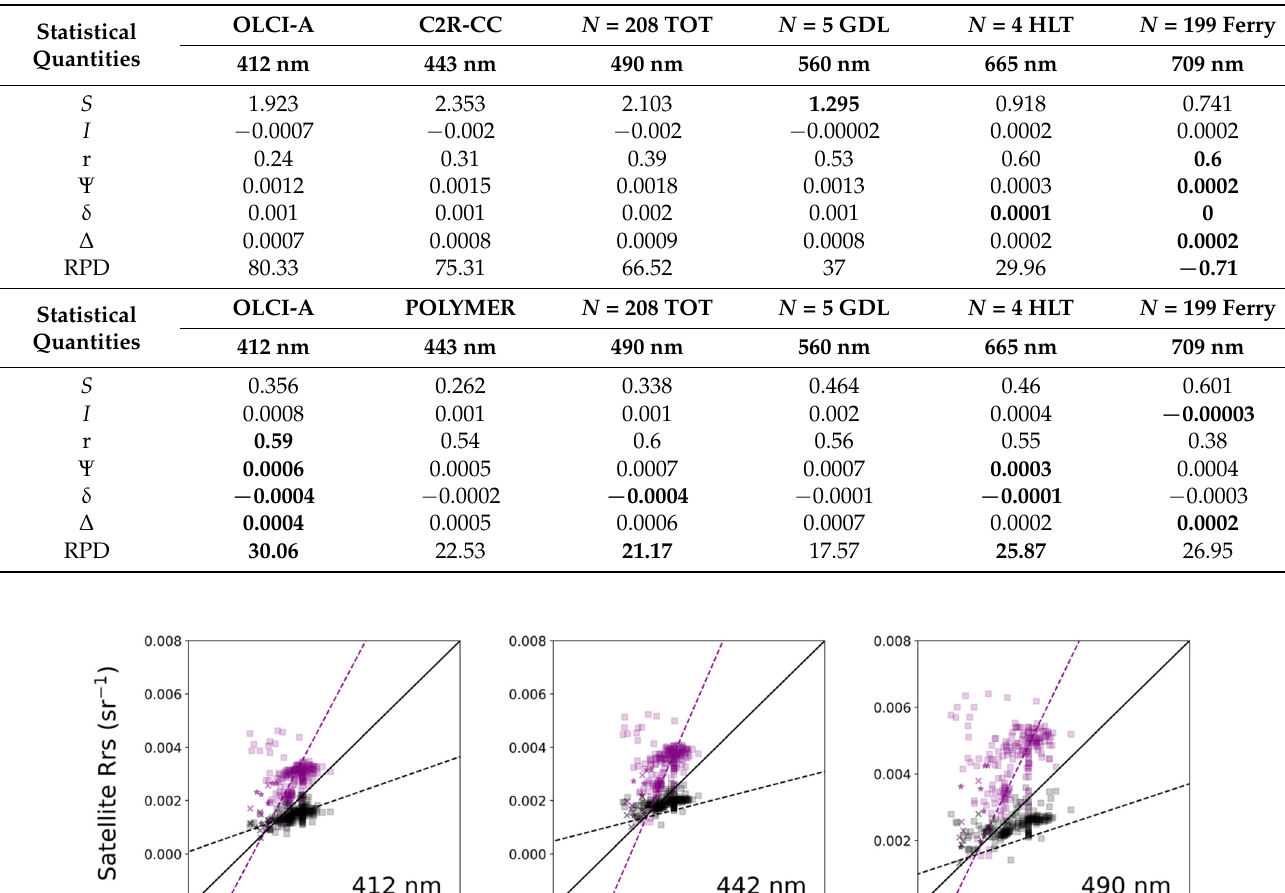
Table 3. Statistical results from the comparison of in situ and OLCI-A CR2-CC vSnap8 and POLY- MER v4.13 R rs ( λ ) . The metrics were computed using type-II regression for the slope ( S ), intercept ( I ), Pearson correlation coefficient (r), root-mean-square difference (RMSD— Ψ ), the bias ( δ ), bias- corrected root-mean-square error ( ∆ ) and the relative percentage difference (RPD). Metrics for the processors with the best performance at each band are given in bold. N is the number of match-ups, with TOT being the total, GDLT is the AERONET-OC site the Gustav Dalen Lighthouse, HLT is the AERONET-OC site the Helsinki lighthouse and Ferry are the Alg@line data.